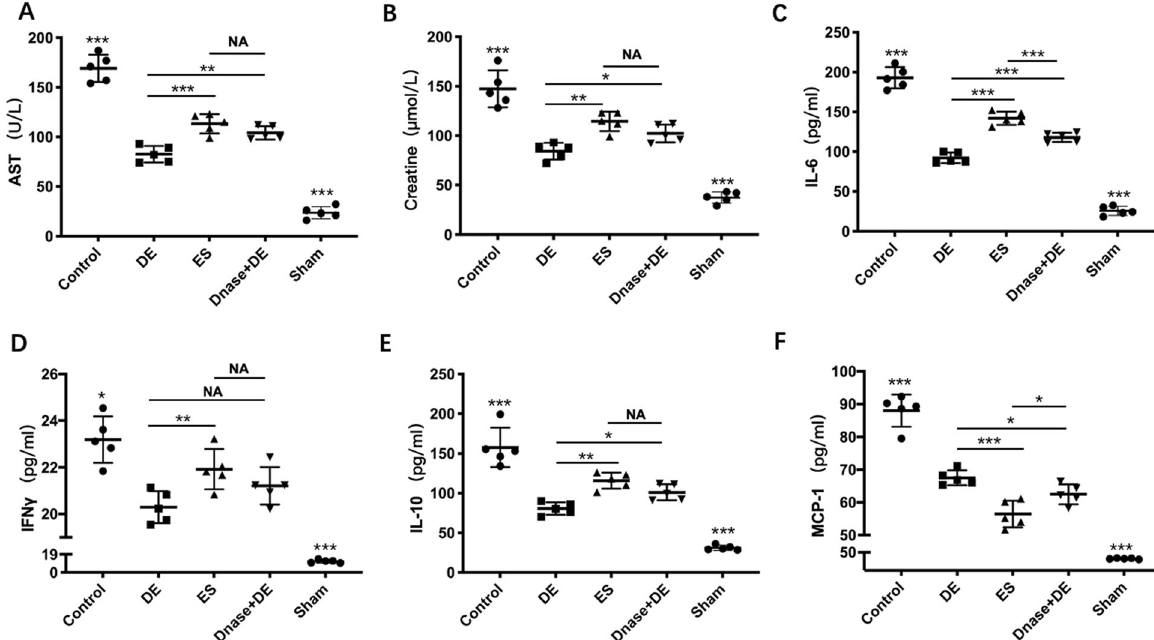
Fig. 5 De-escalation strategy caused less organ injuries and in fl ammatory response attenuated by DNase I in the early sepsis stage. A , B The serum AST and Creatine were determined by ELISA ( n = 25). Reduced levels of AST and Creatine were shown in DE compared with the ES group ( p < 0.01), however, this effect was reversed by NETs scavenger, DNase I ( p < 0.001). C – F The serum levels of IL-6, IFN- γ , IL-10, and MCP-1 were determined using Luminex ® xMAP ( n = 25). The in fl ammatory cytokines levels were lower in the DE group than that in the ES group ( p < 0.01), except for the level of MCP-1 ( p < 0.001). When DNase I was administrated, all were elevated compared with the DE group ( p < 0.05). DE de-escalation. ES